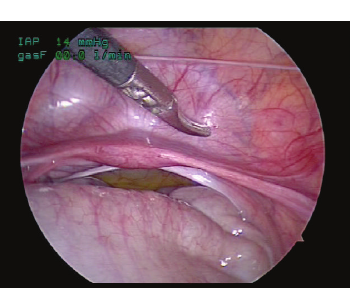
Figure 3: The ureter is mobilized while the assistant maintains traction with a vessel loop.